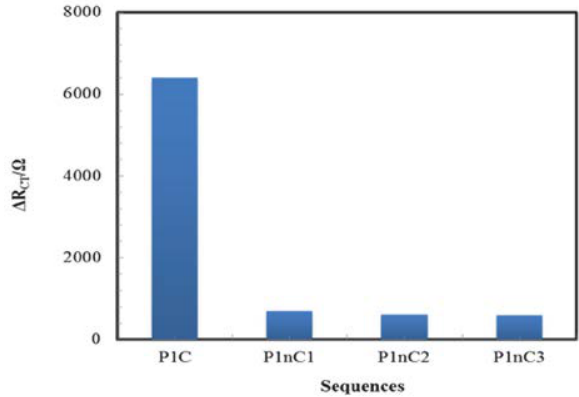
Figure 8. The specificity test using the MCH/ssDNA/AuNPs/SF/ GO/GCE biosensor responses to different targets of complementary (P1C) and non-complementary (P1nC1, P1nC2 and P1nC3) se-